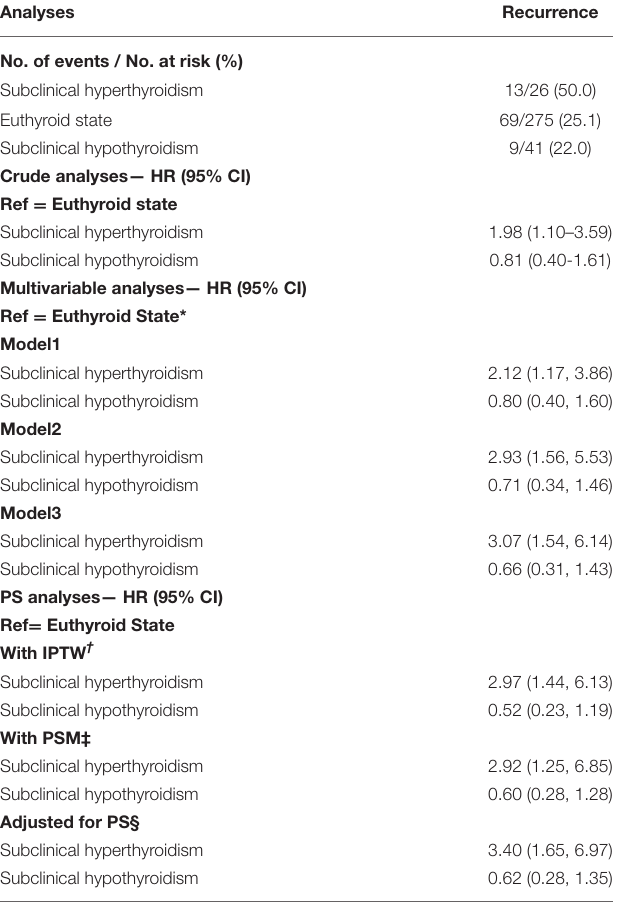
multivariate, and PS